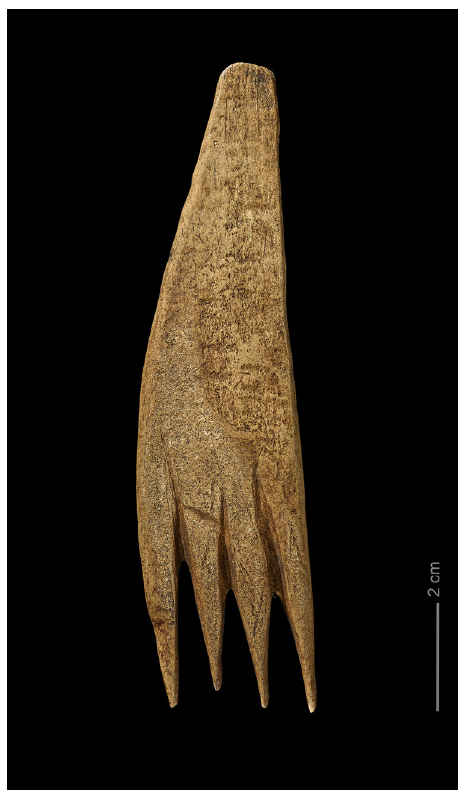
Figure 7: Bone comb, possibly used to split sinew into thin thread, from Rissebávti/Gressbakken Nedre Vest house 4. Photo by M. Karlstad, UiT – The Arctic University of